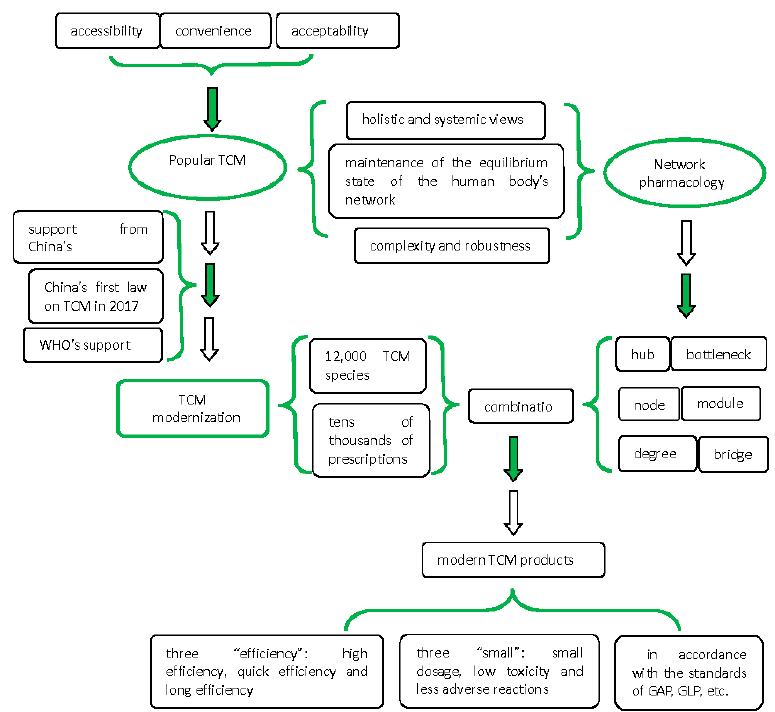
Figure 2. Traditional Chinese medicine (TCM) modernization and network pharmacology.